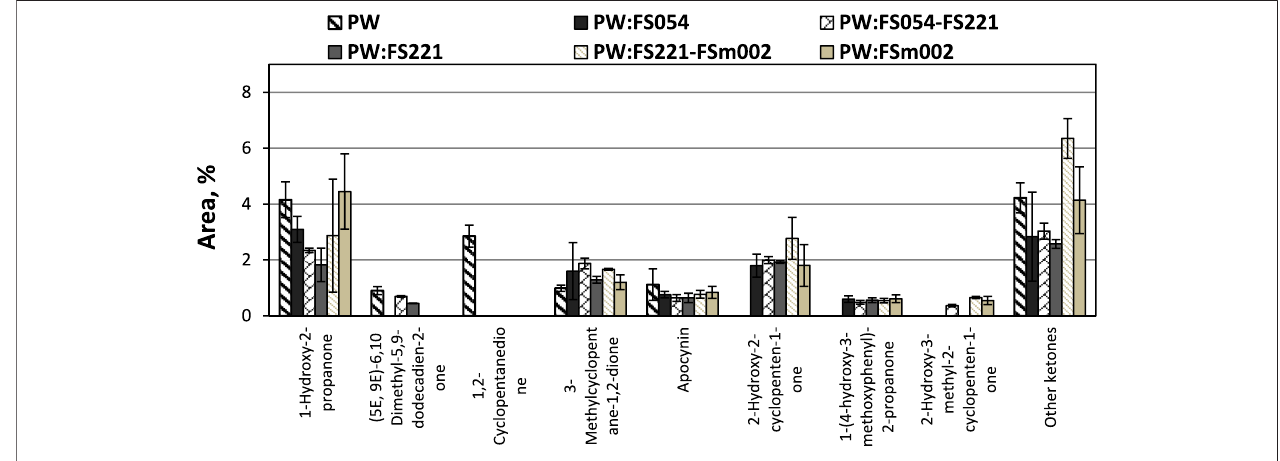
FIGURE 10 | Effect of mono- and dual-sized α -Fe 2 O 3 catalyst particle mixtures on the PW CFP ketones distribution.